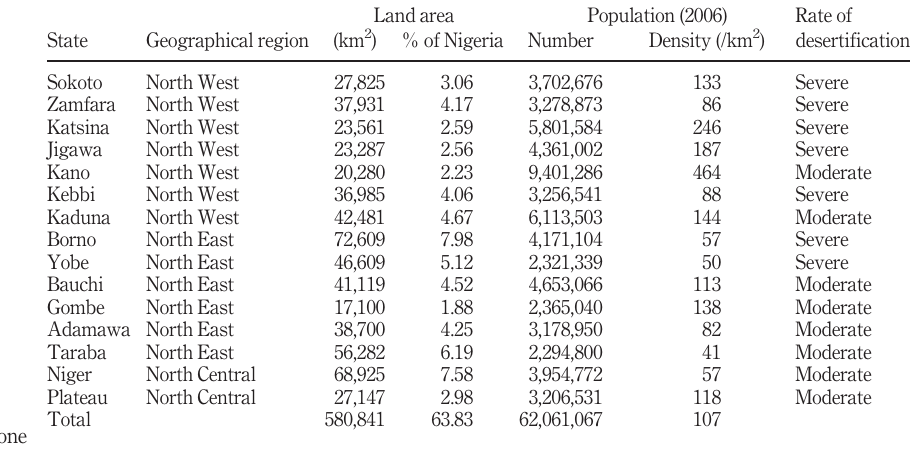
Table 2. Deserti fi cation-prone frontline